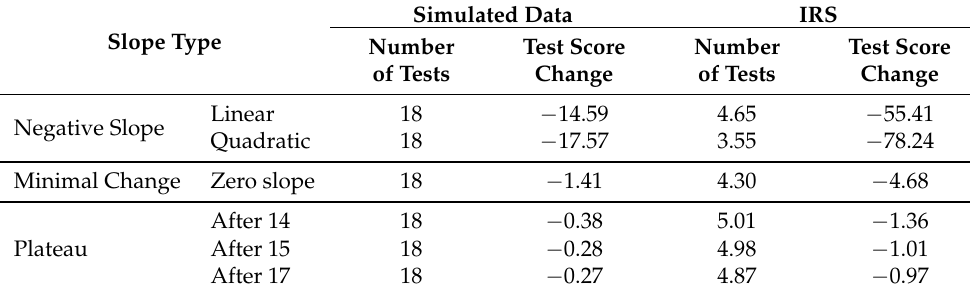
Table 4. Results of the simulation study for the full-data